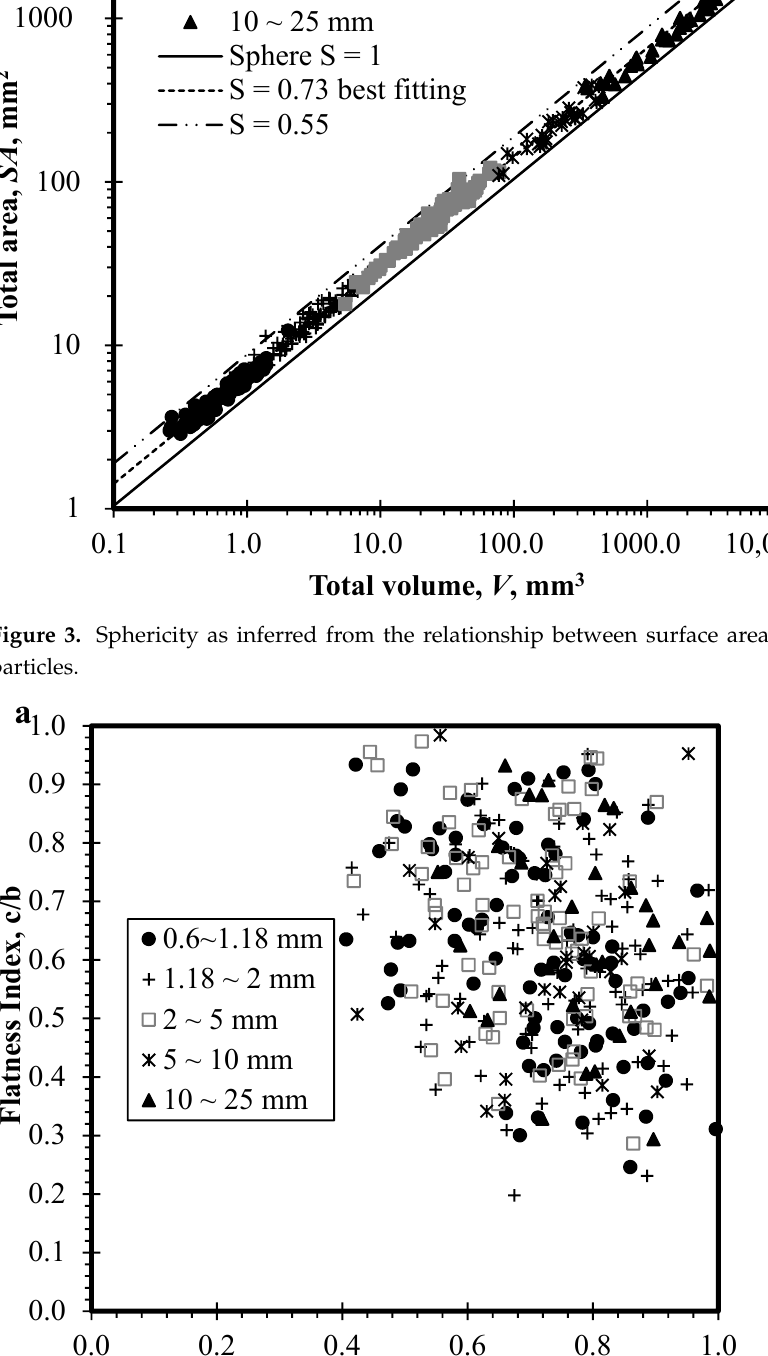
Figure 4. Correlation ( a ) between Flatness Index and Elongation Index where a ≥ b ≥ c represents the major, intermediate, and minor axes, respectively and ( b ) between average aspect ratio and sphe- ricity. The roundness is mostly in the range of 0.55 to 0.8 and appears to be in an inverse relationship with sphericity, i.e., larger sphericity is accompanied by a smaller roundness (Figure 5a). The FD spans a wide range from around 2.1 to 2.7 (Figure 5b). The FD for